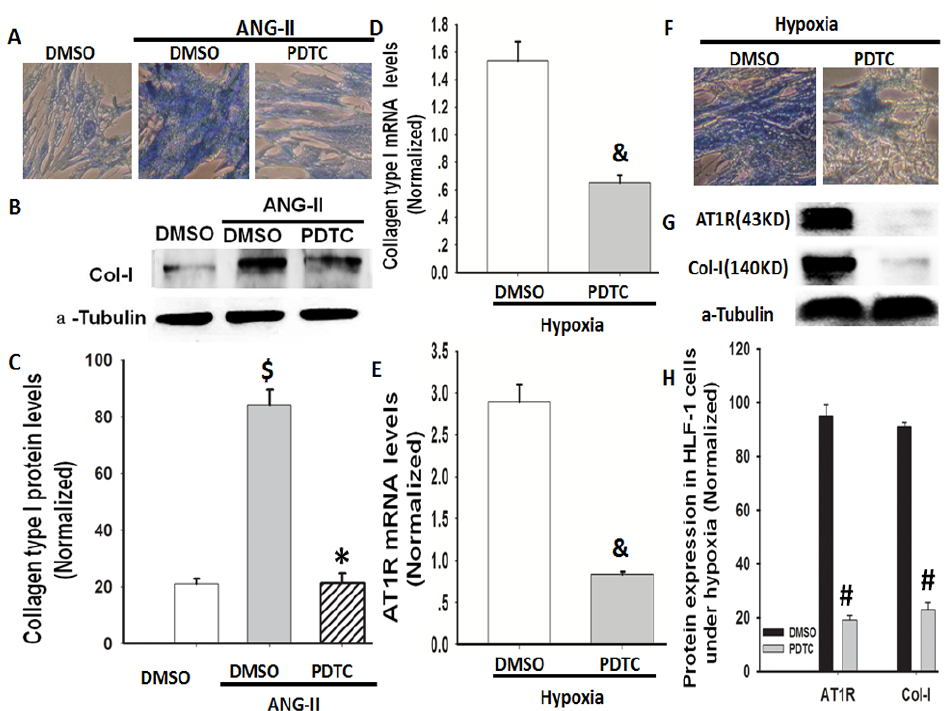
Figure 6. The role of NF- κ B in hypoxia-induced Col-I expression under Ang II and hypoxic conditions. ( A ) A representative picture of the Masson staining in HLF-1 cells after the 1.0 μ M Ang II treatment with or without PDTC (100 μ M) for 24 h; ( B ) The Col-I protein expression level was measured using Western blot analysis; ( C ) Normalisation of the Col-I expression to α -tubulin. The data are presented as means ± SD ( n = 3). $ p < 0.05 vs. DMSO; * p < 0.05 vs. Ang II; ( D , E ) The Col-I and AT1R mRNA expression levels were measured using RT-PCR. & p < 0.05 vs. 24 h following hypoxia